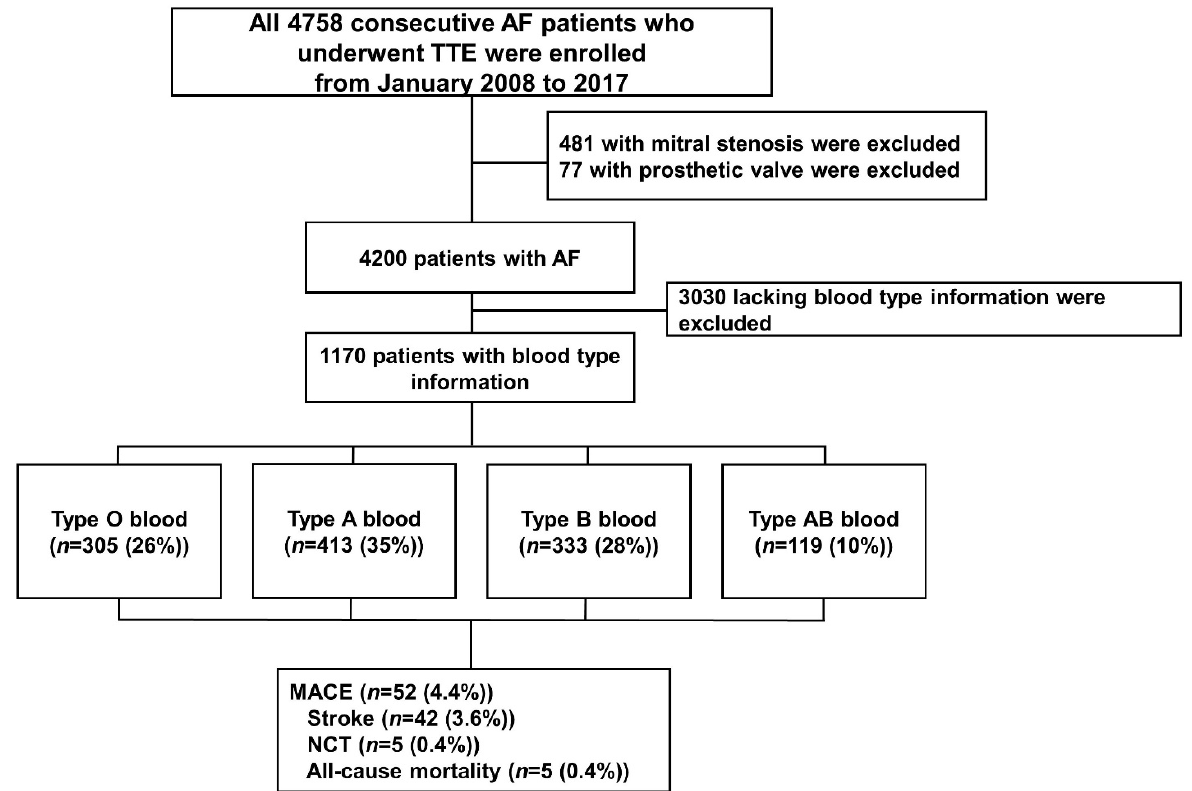
Figure 1. Diagram for enrollment. After the exclusion of 558 patients with valvular diseases, 4200 patients with nonvalvular atrial fibrillation were analyzed. A total of 1170 patients were enrolled after the exclusion of 3030 patients for whom no blood type information was available. AF, atrial fibrillation; NCT, non-cerebral thromboembolism; TTE, transthoracic echocardiography.